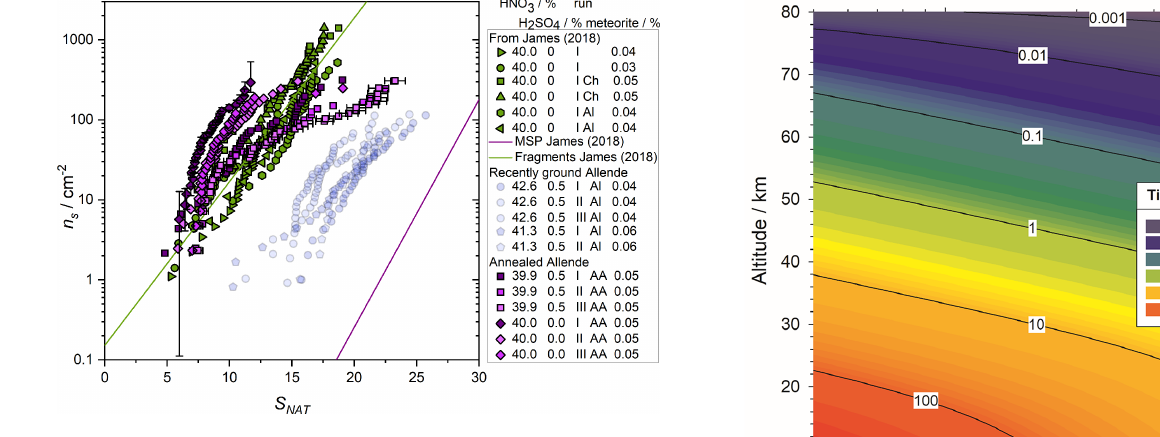
Figure 4. Nucleation effectiveness represented by the number of sites active per unit surface area, n s , under particular conditions, represented here by the saturation ratio with respect to nitric acid trihydrate (NAT) of meteoric fragment analogues with (blue) and without (green) H 2 SO 4 . As in James et al. (2018), unlabelled data are from experiments using the Northwest Africa 2502 meteorite, Ch indicates the Chergach meteorite, Al indicates Allende (see that work for details of sample preparation and experimental setup). Here, AA (purple data) indicates a sample of the Allende meteorite annealed to simulate relatively mild heating on atmospheric entry which could lead to fragmentation (see text for details). Green sym- bols with the exception of diamonds are from James et al. (2018). Blue data show experiments containing H 2 SO 4 . One data set is pre- sented with vertical error bars which illustrate the contribution to the uncertainty of the randomness of the distribution of nucleating sites between droplets. A second data set shows the temperature un- certainty of the instrument propagated into saturation terms. These uncertainties are of similar magnitude for other data sets but are omitted for clarity.